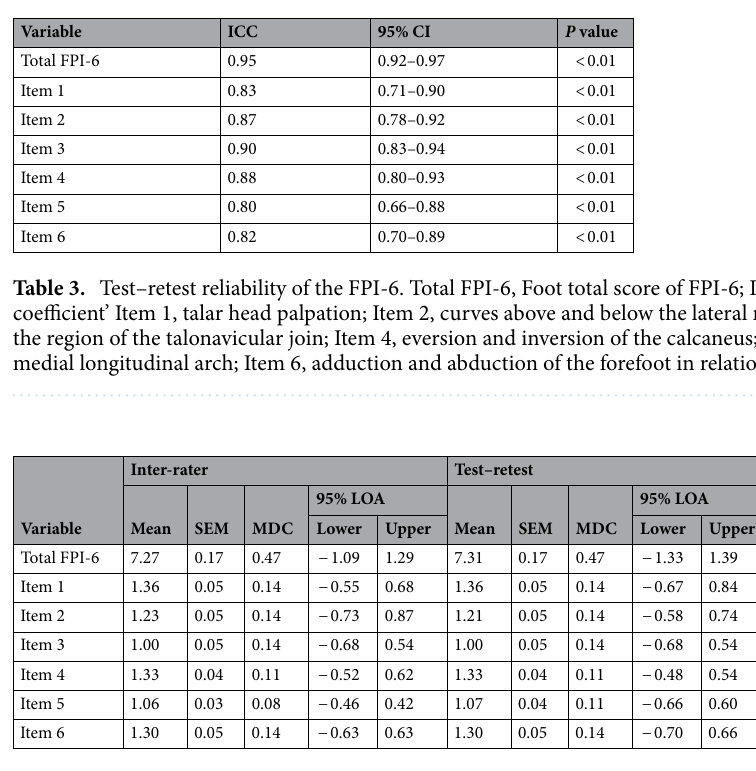
Table 4. The SEM, MDC and 95% LOA of inter-rater and test–retest. Total FPI-6, Foot total score of FPI-6; LOA, Limit of Agreement; MDC, minimal detectable change; SEM, standard error of measurement; Item 1, talar head palpation; Item 2, curves above and below the lateral malleolus; Item 3, a bulge in the region of the talonavicular join; Item 4, eversion and inversion of the calcaneus; Item 5, congruence of the medial longitudinal arch; Item 6, adduction and abduction of the forefoot in relation to the rear